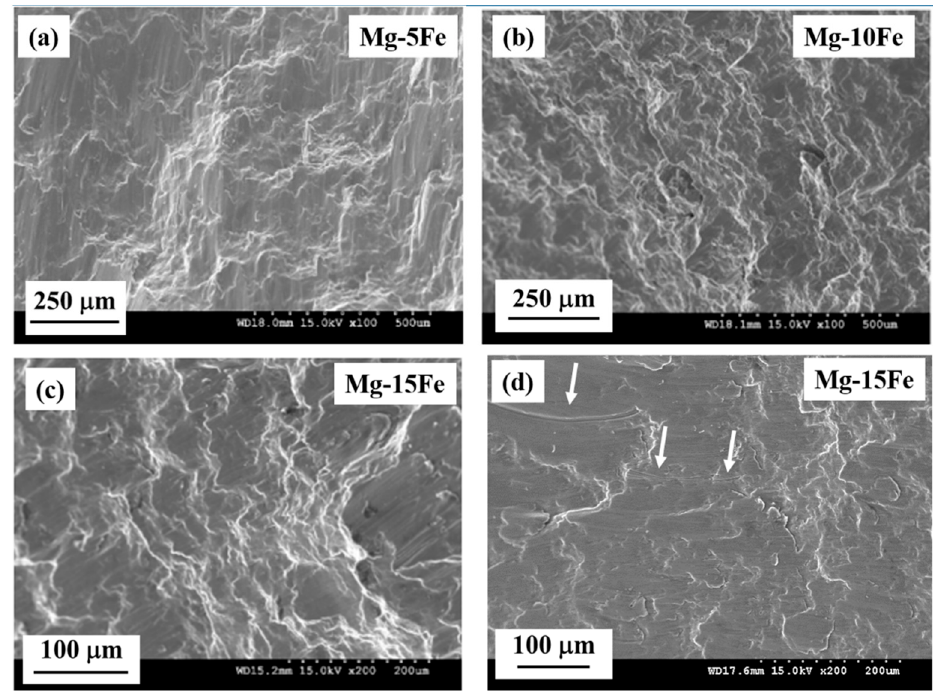
Figure 8. SEM fractography of compression tested samples showing shear fracture: ( a ) Mg-5Fe;